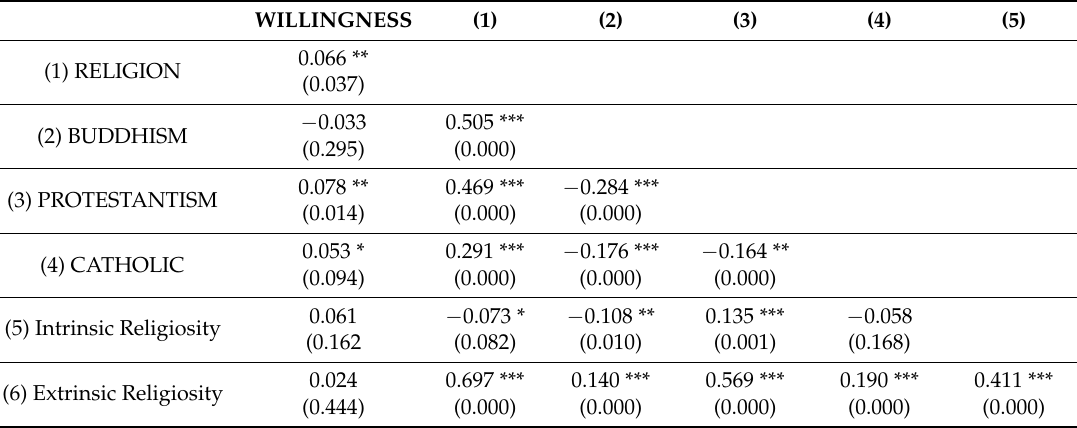
Table 3. Correlation among the variables of willingness to donate organ, religion, and religiosity.